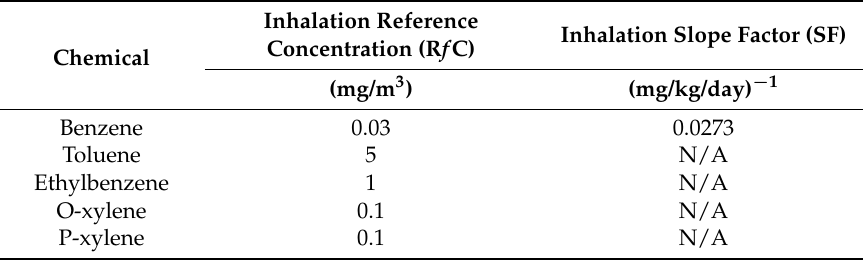
Table 2. Benzene slope factor, and toluene, ethylbenzene, and xylenes (TEX) inhalation reference